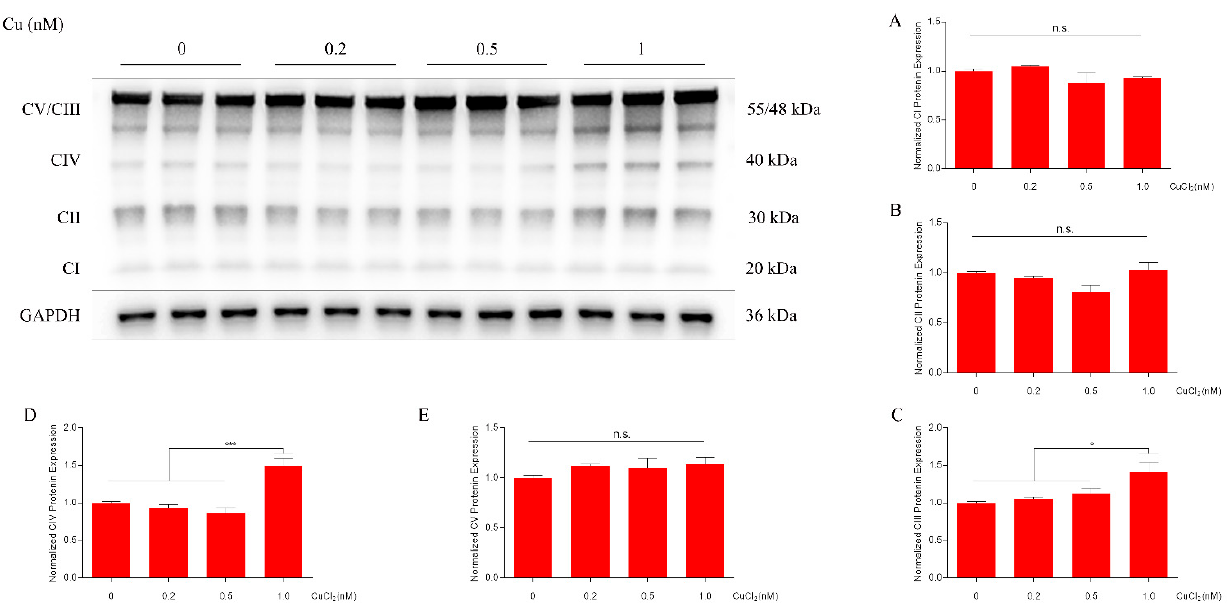
Figure 2. Western blot showing respiratory complexes in dermal papilla cells following 24 h Cu treatment (0, 0.2, 0.5, 1 µM). Complexes I–V are referred to as CI ( A ) (mol. wt. ~19 kDa), CII ( B ) (mol. wt. ~30 kDa), CIII ( C ) (mol. wt. ~48 kDa), ( D ) CIV (mol. wt. ~40 kDa), and ( E ) CV (mol.wt. ~55 kDa), respectively. Significance was calculated using one-way ANOVA with Tukey post-test for comparing multiple groups. n.s. represents no significant difference. * p < 0.05, *** p < 0.001.